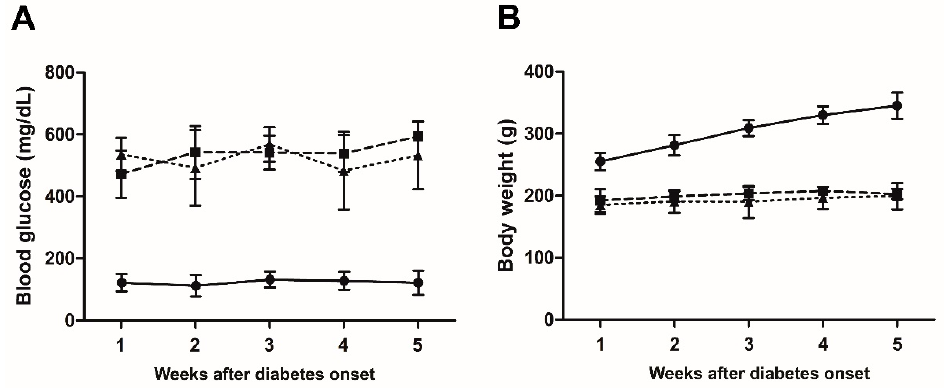
Figure 4. Blood glucose levels and body weight (means ± SD) of rats during five weeks after diabetes onset in STZ rats. Mean blood glucose levels ( A ) and body weight ( B ) were recorded in control rats ( n = 5, circles), in STZ rats ( n = 5, squares), and in STZ rats treated with LG ( n = 5, triangles).